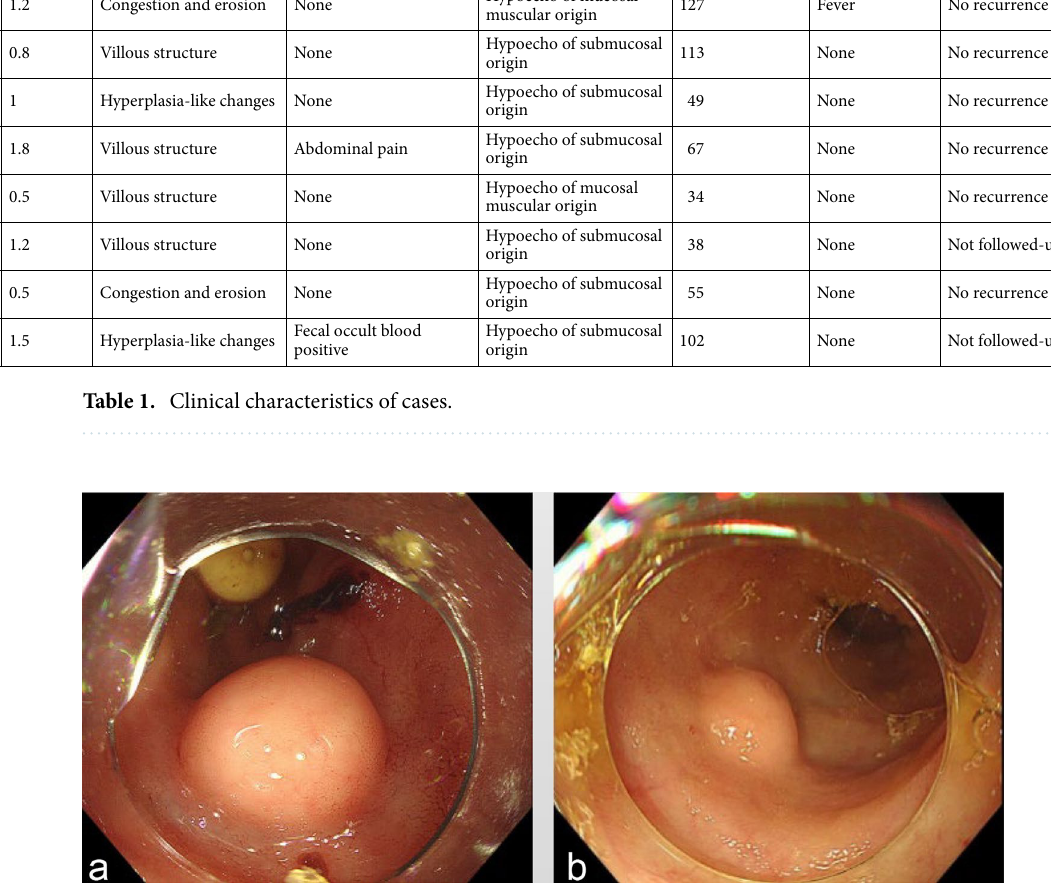
Figure 1. White Light Endoscopes: The mucosa is protruded, with a smooth, slightly yellow surface. ( a ) The mucosa showed bubble-like protuberance. ( b ) The mucosa showed mound-like